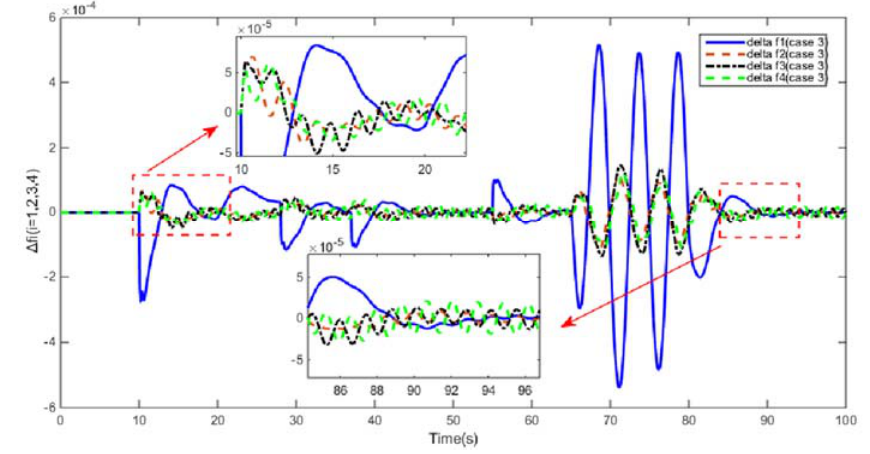
Figure 9. ∆ f ( i = 1,2,3,4 ) of each power system under load disturbance in Case 3.